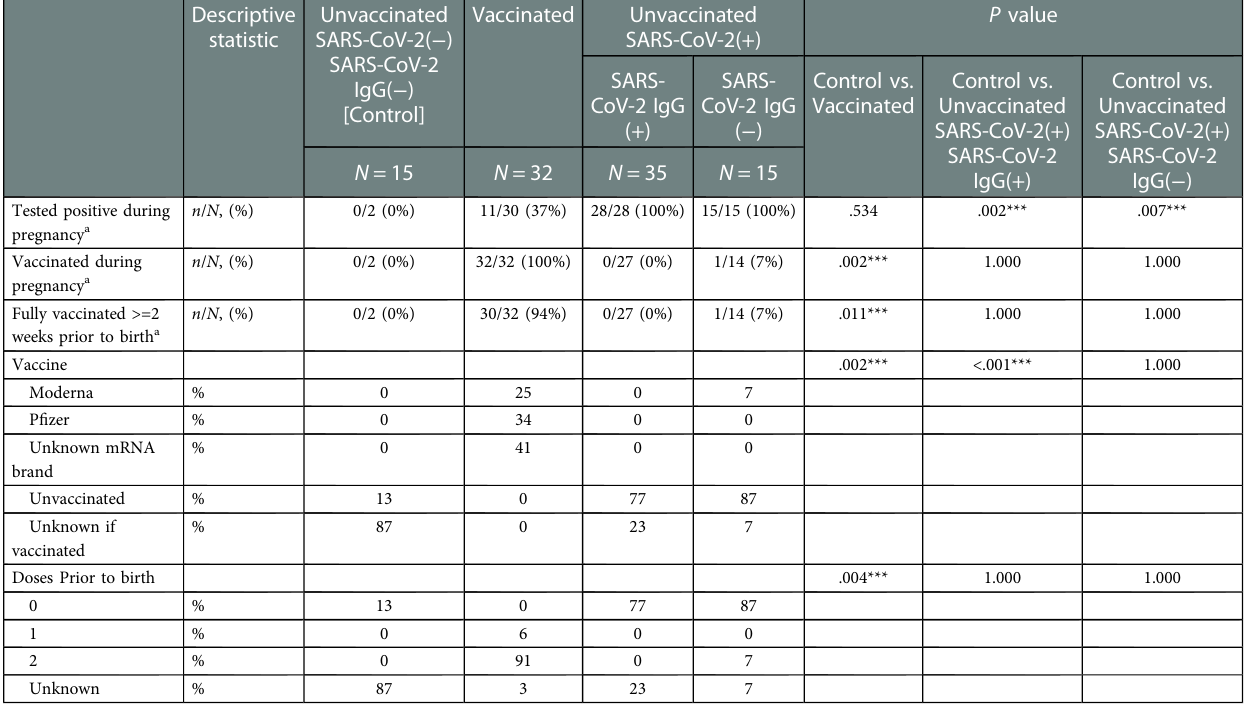
TABLE 1 Maternal vaccination and SARS-CoV2 exposure data strati fi ed by study groups based on SARS-CoV2 exposure/vaccination and presence of neonatal SARS-Cov2 speci fi c IgG, N =97. Descriptive